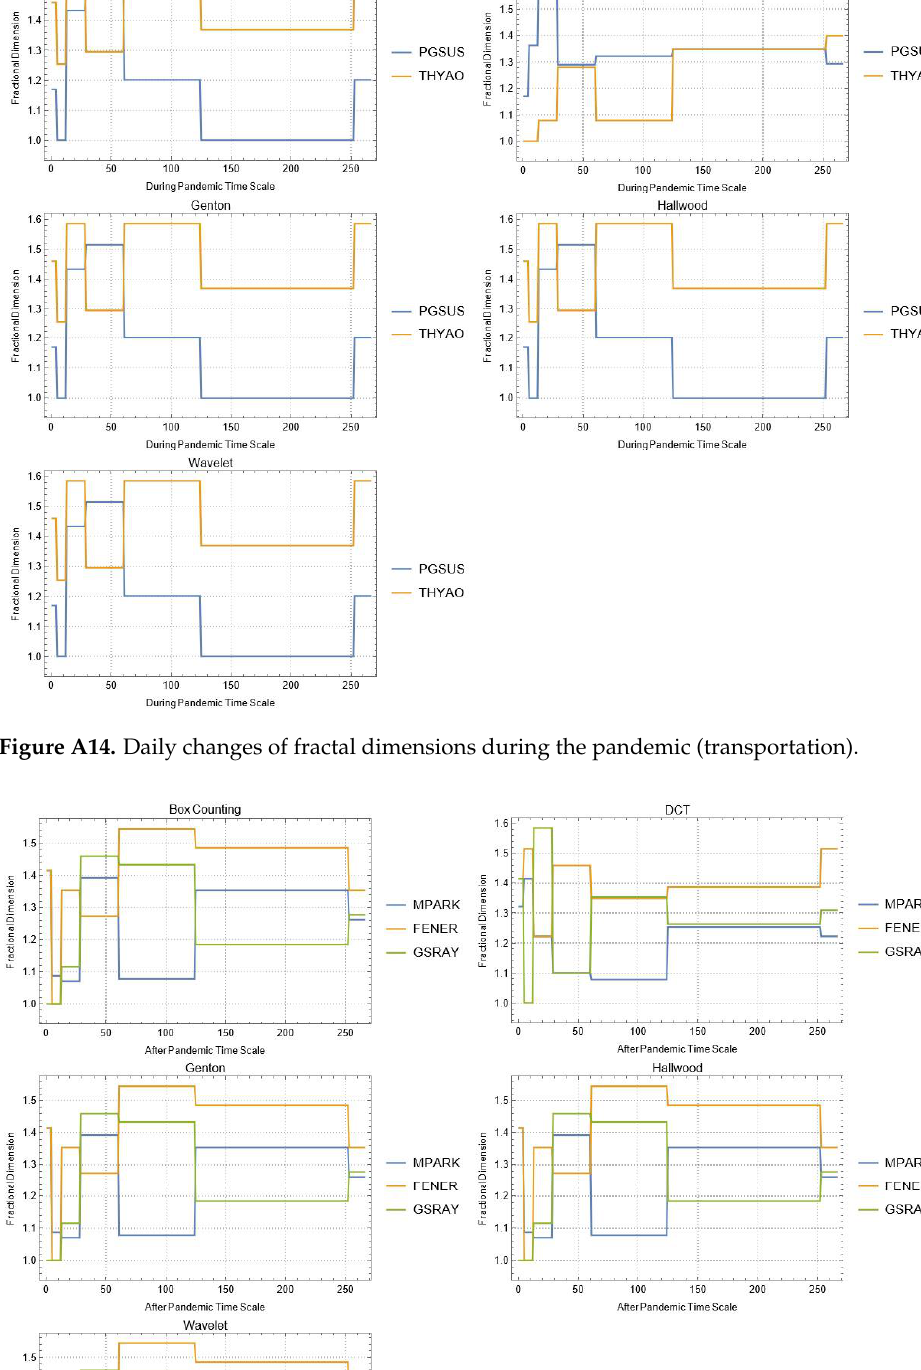
Figure A13. Daily changes of fractal dimensions during the pandemic (wholesale–retail).